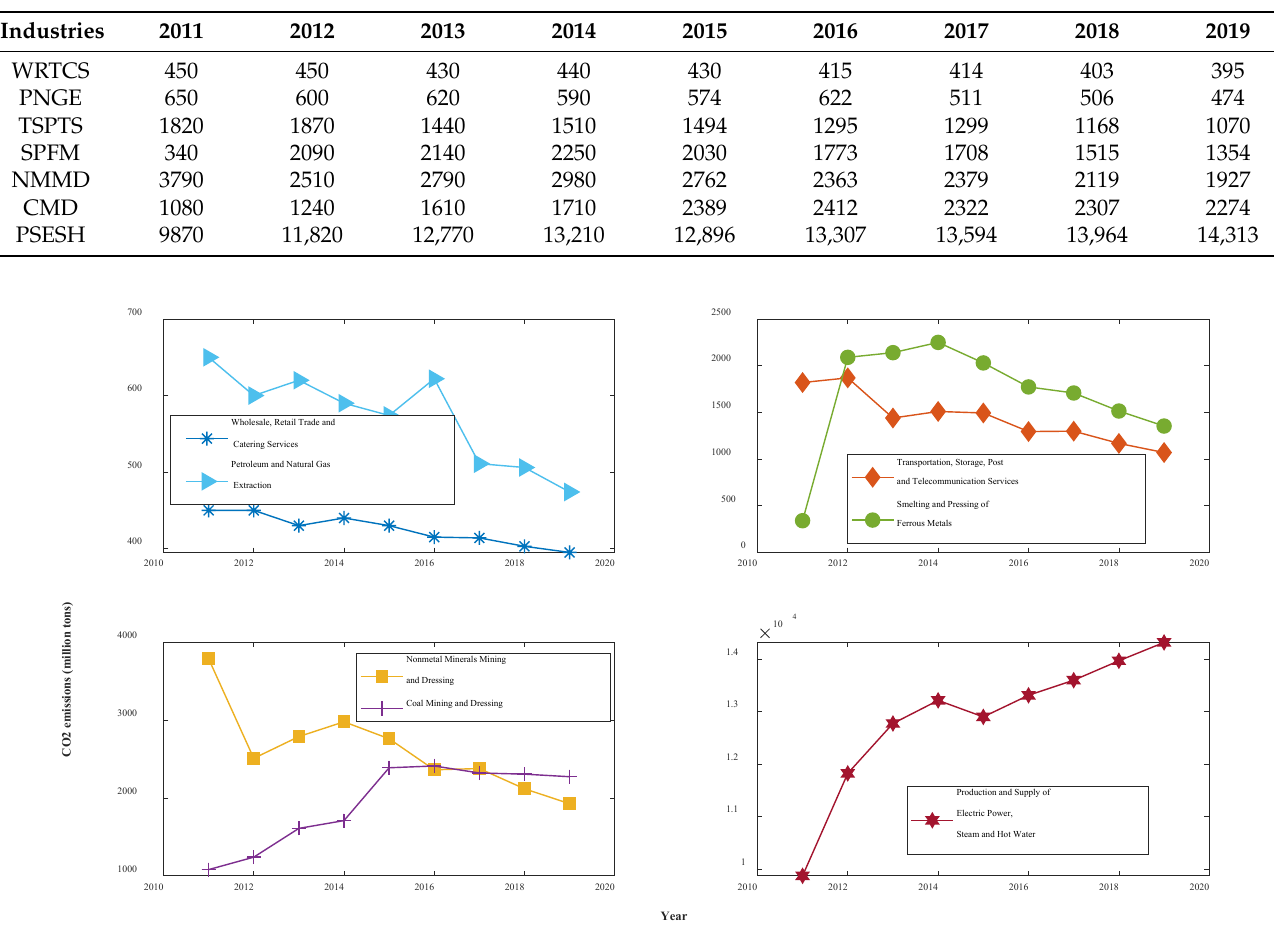
Figure 2. Trends of CO 2 emissions for 7 industries in Shaanxi, 2011–2019. Carbon emissions data from seven industries are analyzed and compared using three models, NFOGBM, FANGBM, and NGBM, to predict data for two years, 2018 and 2019. Then, the simulation, prediction, and overall performance of the three models are assessed. (1) The modeling results for WRTCS are shown in Table 2, and the fitted curves and error plots are shown in Figure 3. The MRPESs (%) of the NFOGBM, FANGBM, and NGBM are 0.561, 0.6, and 0.647, respectively; the MRFPEs (%) are 0.333, 1.932, and 1.847, respectively, and the CMRPEs (%) are 0.504, 0.933, and 0.947, respectively. It can be seen that the simulation errors of the three models are not very different, but the NFOGBM has a much lower prediction error and integrated error than those of the other two models, indicating that the NFOGBM provides the optimal simulation, prediction, and integrated performance. In addition, the curves obtained with the NFOGBM are closest to the original data, indicating that the model provides the best predictions of future scenarios. It is worth noting that the FANGBM reduces the simulation error to some extent but increases the prediction error compared to the